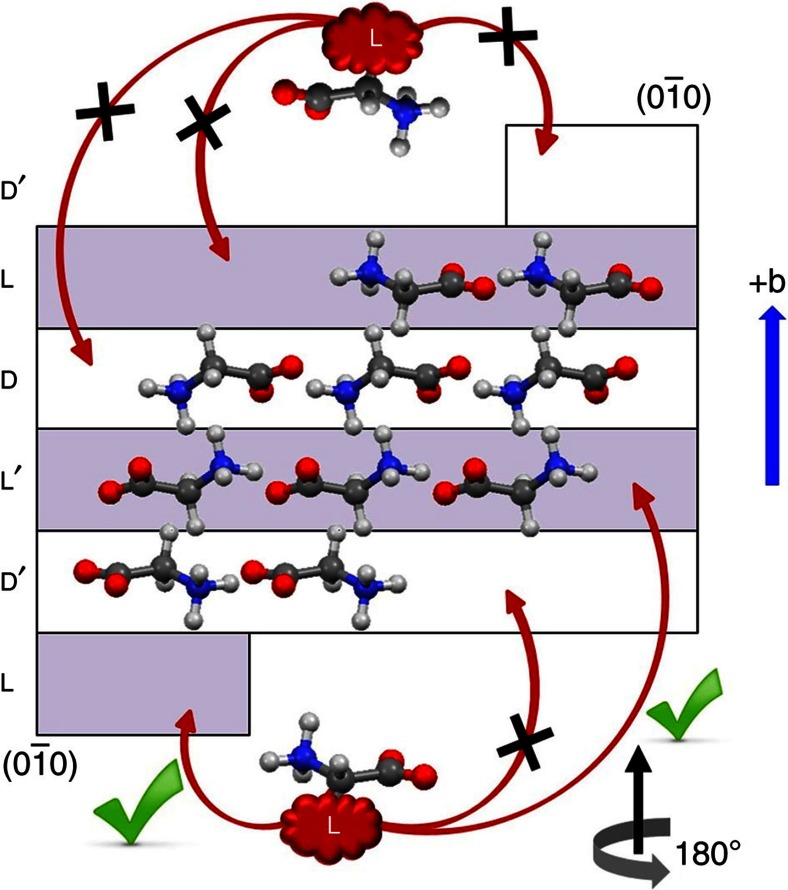
Polar occlusion of a guest L-enantiomer through the () face of α-glycine.The L-amino acids interact enantioselectively with molecules of the D and D′ layers through zwitterionic interactions to occupy the L and L′ sites56.